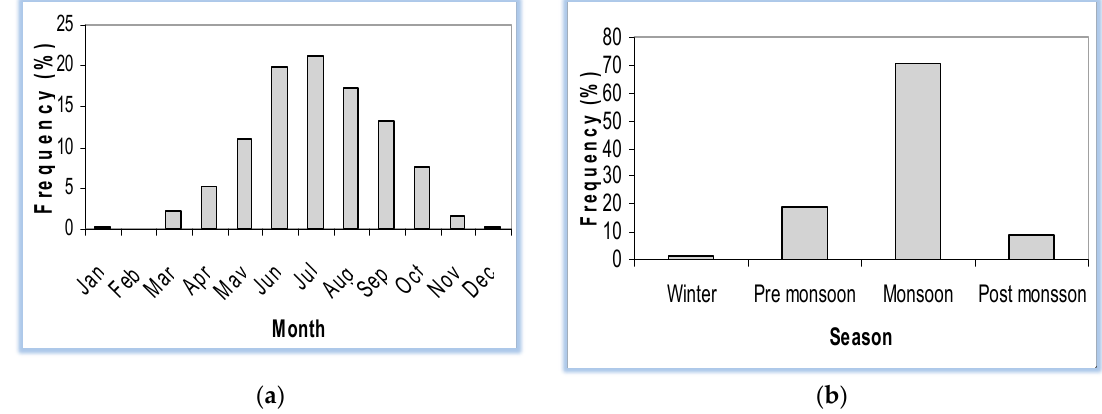
Figure 1. Monthly ( a ) and seasonal ( b ) percentage of the total annual rainfall during 1948–2017.